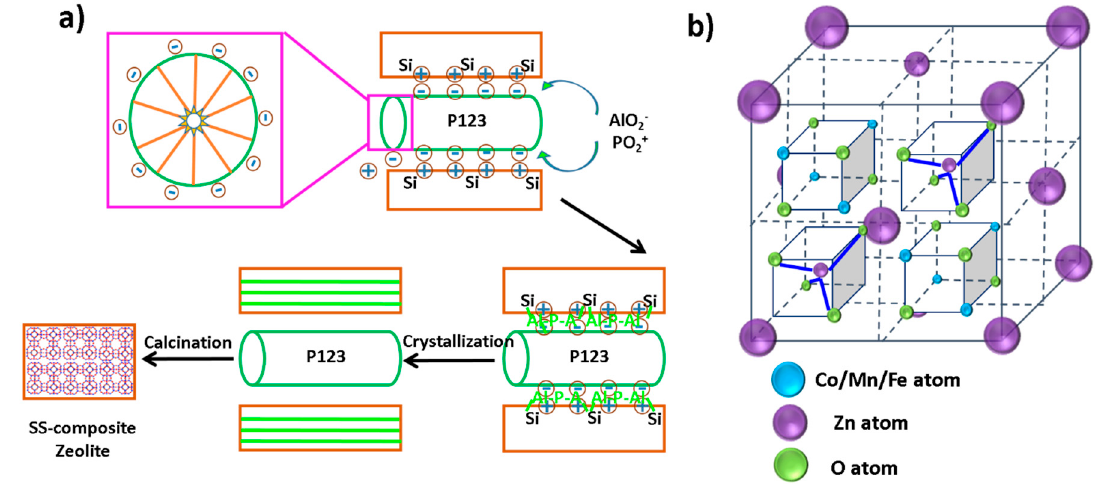
Figure 9. Schematic illustration of ( a ) synthesis of silicoaluminophosphates (SAPO)-34@as-synthesized SBA-15 (silica sphere (SS) composite zeolite) using triblock copolymer (P123) templates; ( b ) ZnCo 2 O 4 structure [152].